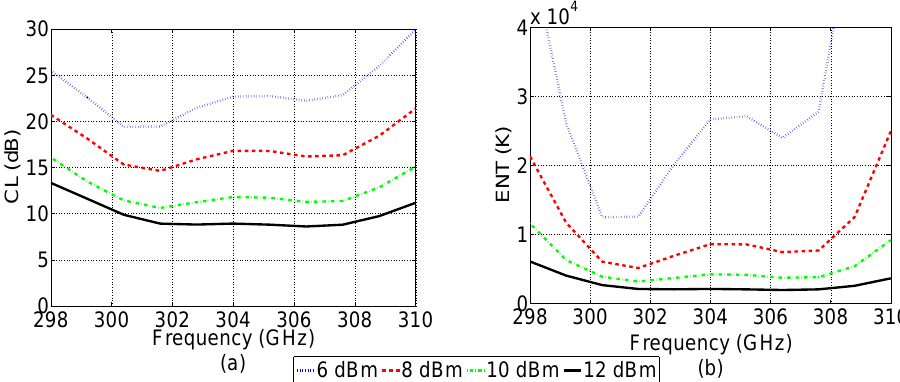
Figure 7. Predicted results of combined frequency doubler/subharmonic mixer for for different LO input power levels: ( a ) Conversion Loss and ( b ) DSB Equivalent Noise